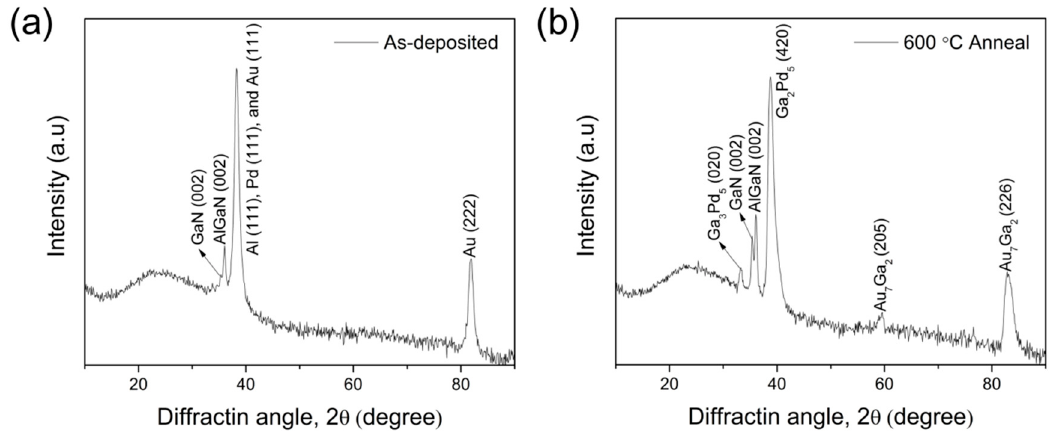
Figure 2. X-ray diffraction (XRD) plots of the PdAl/Au metal stack on p-AlGaN ( a ) as-deposited and ( b ) annealed at 600 ° C.